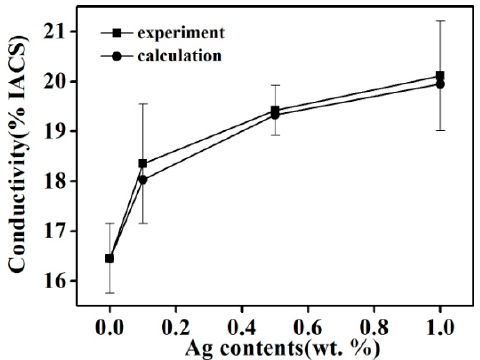
Figure 8. Experimental and calculated values of the conductivity of Cu–14Fe–xAg alloy (x = 0, 0.1, 0.5, 1).